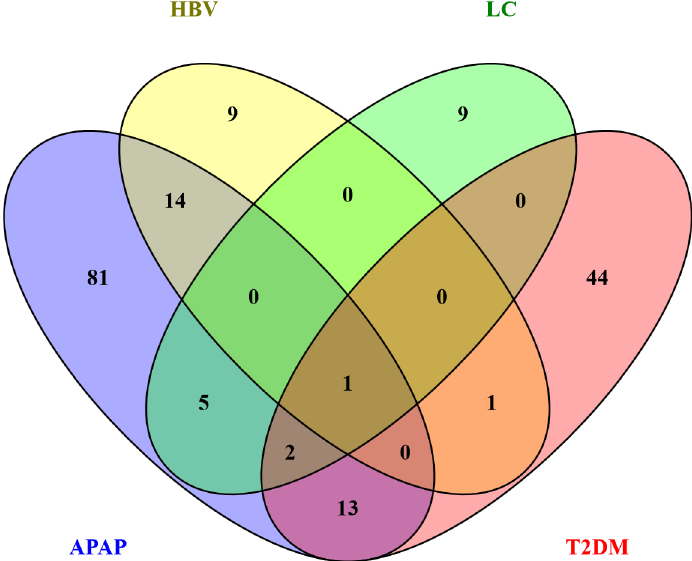
Fig 2. Overlap of individual miRNA signatures. The Venn diagram shows minimaloverlap betweenthe liver impairments and T2DM. In total 179 miRNAs were identified(116 in APAP, 25 in HBV, 17 in LC and 61 in T2DM) of which only 1 miRNA was significantly altered among all